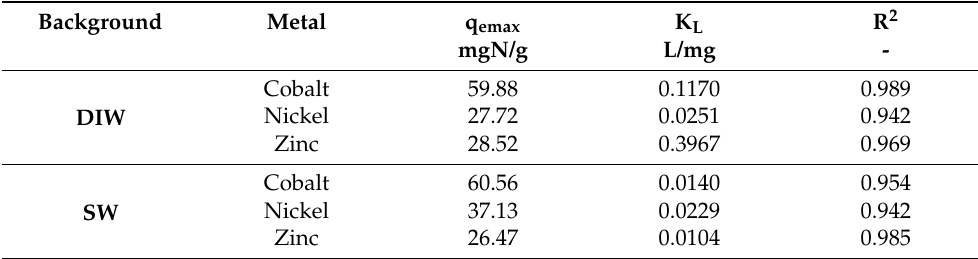
Table 3. Results of the regression calculation of the Langmuir model parameters for the isotherms data (Figure 3) for Co-, Ni-, and Zn-HCF in DIW and SW background. Background